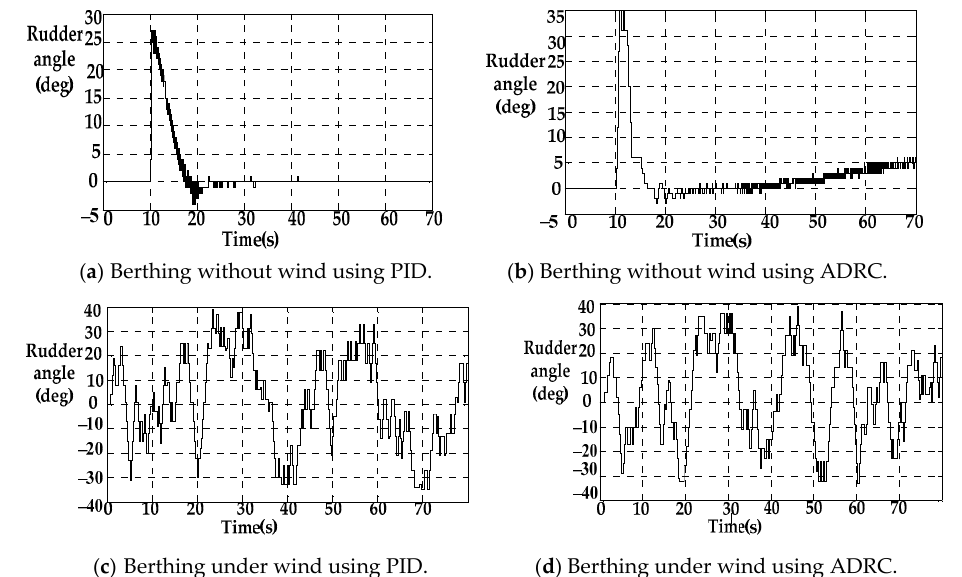
Figure 13 . Ship rudder angle in the simulation of ship automatic berthing.